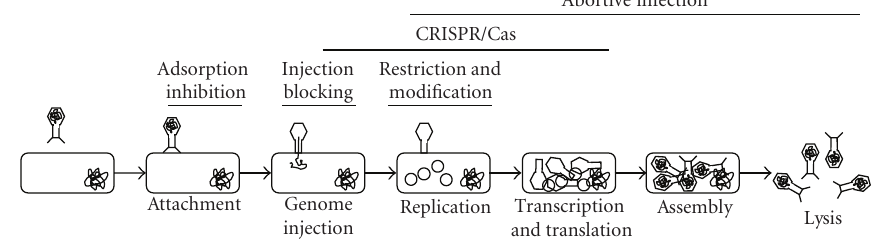
Figure 1: Bacteria can acquire phage resistance against most stages of the phage lifecycle. Fortunately, we can use our knowledge of these systems and the ability to evolve or isolate phage that infect resistant strains to minimise or avoid resistance (see text for